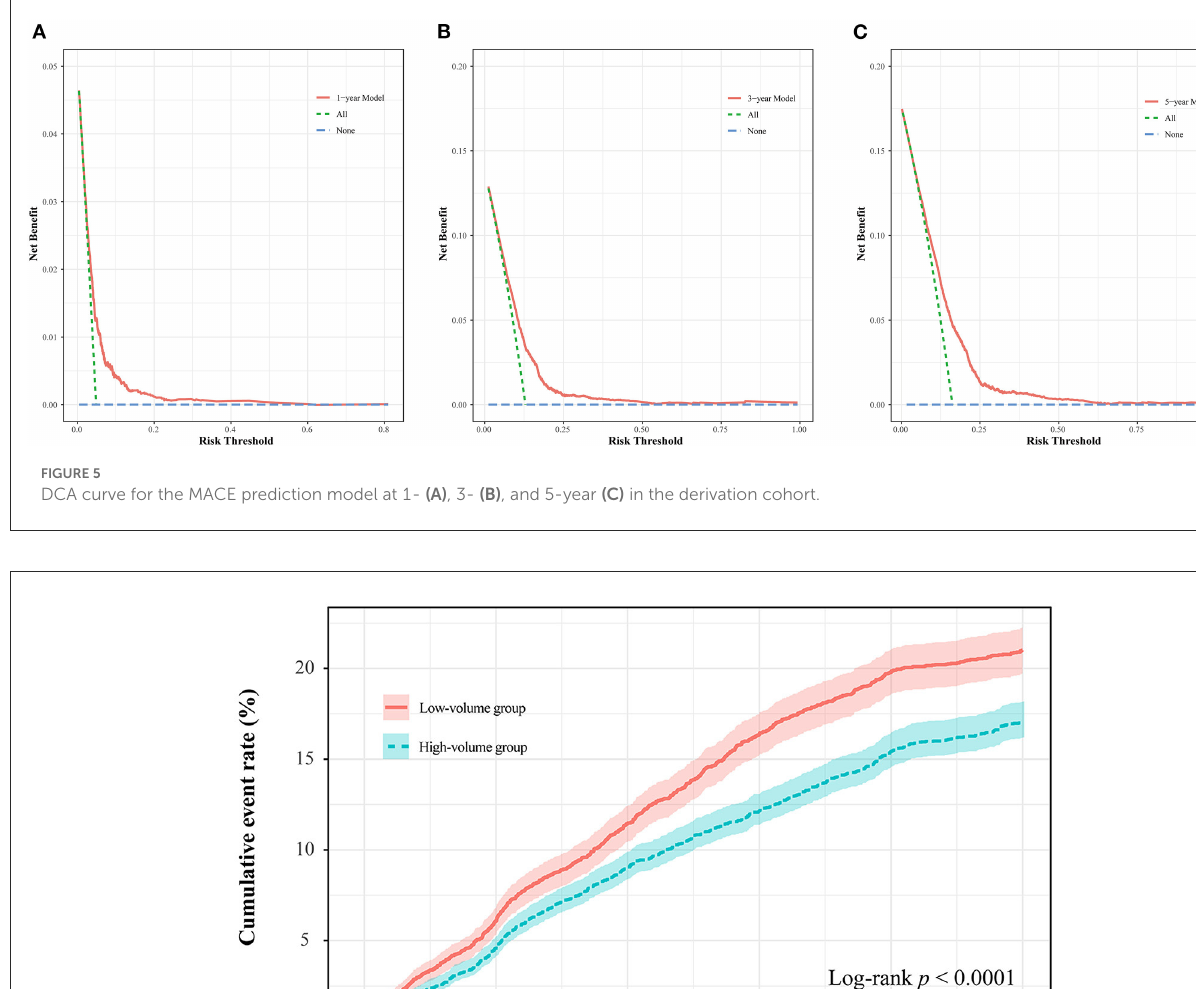
didn’t compare our model with other international models in the same cohort. Third, some potential variables were not involved in our model, such as the indices of cardiopulmonary exercise testing (CPET) and PCI-related parameters. However, our study population was ACS patients undergoing coronary angiography and the inclusion criteria were not limited to cases with CPET and PCI. Finally, the role of exercise volume including exercise intensity and cumulative time was not consistent during the whole process of study. As a result, the exercise volume was defined as the average level after collecting the related follow- up